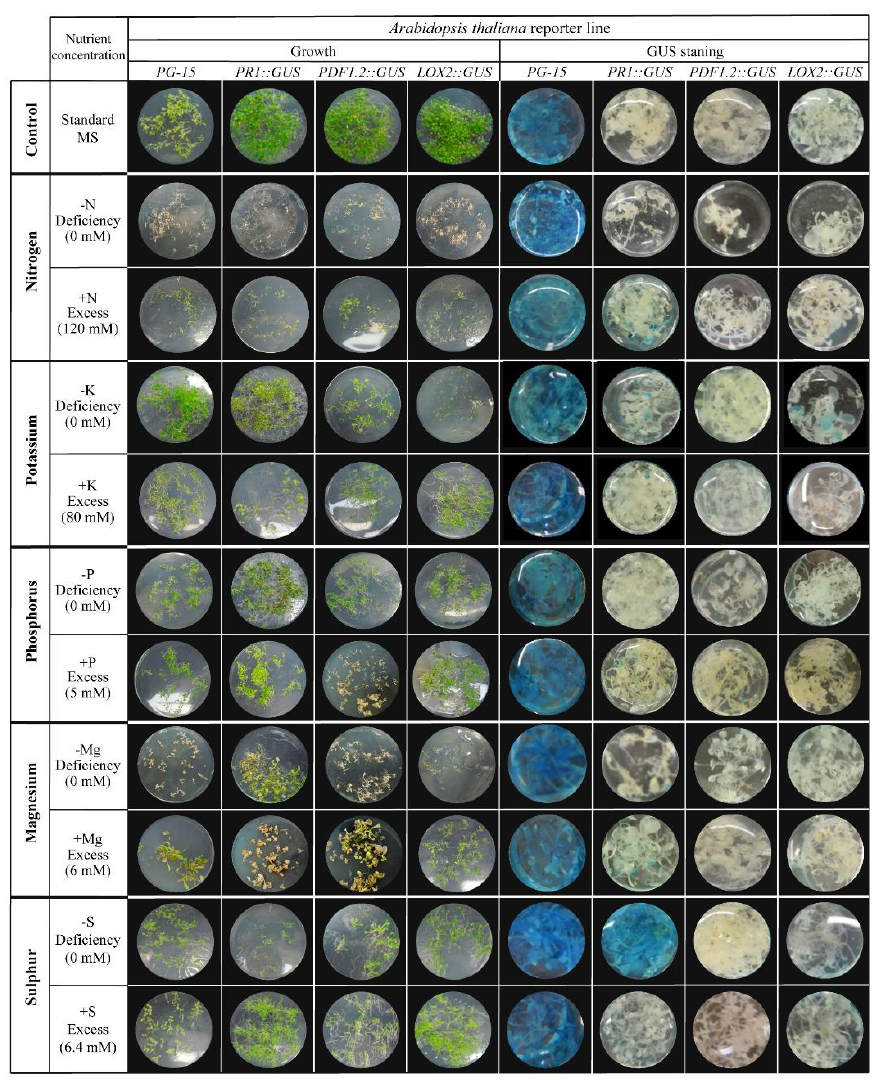
Figure 1. Arabidopsis thaliana responses to nutritional stress generated by the absence or excessive concentrations of nitro- gen, potassium, sulfur, magnesium, or phosphorus under in vitro conditions. Growth and GUS-staining of 3-week-old plants of PG-15::GUS, PR1::GUS, PDF1.2::GUS, and LOX2::GUS reporter lines are shown. PG-15::GUS was used as a posi- tive control for